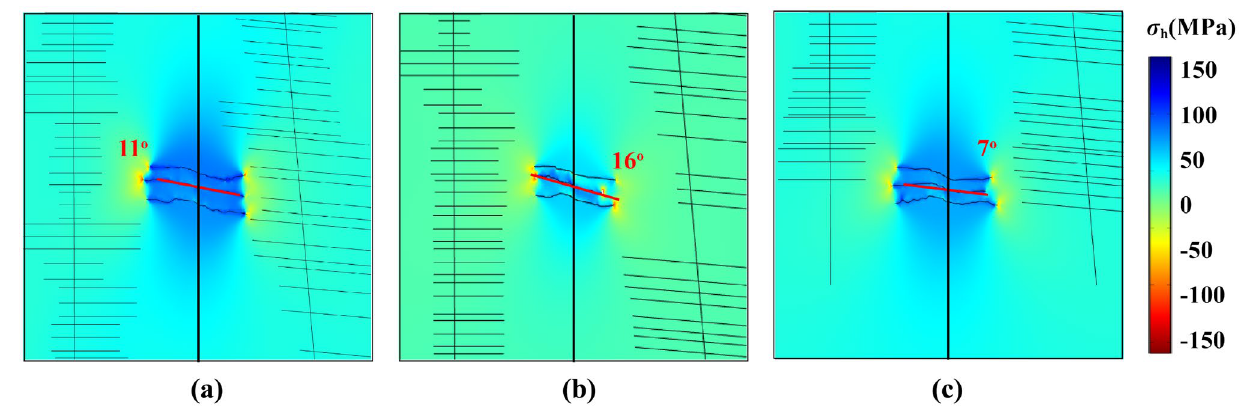
Fig. 19 Influences of the distance to the parent wells on the fracture configuration of a the 7th, b 16th and c 25th stage